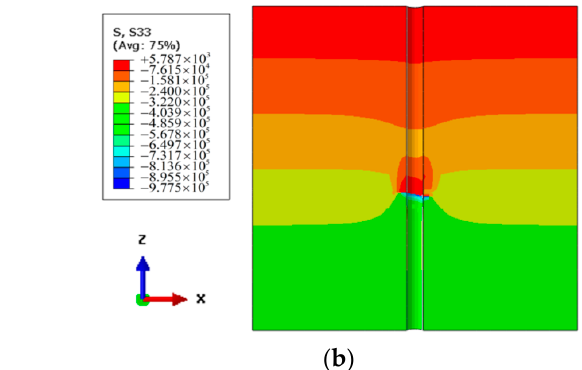
Figure 6. Displacement nephogram of soil around the piles. ( a ) Monopile; ( b ) Helical pile. As shown in Figure 7, vertical stress changes slightly at the pile end, and stress mutation occurs at the pile end, which is more obvious with the ordinary pile. Stress in the upper part of the pile tip is larger than that in the lower part. Compared with the monopile foundation, the area of concentrated stress in the helical pile foundation is smaller and the stress is higher.